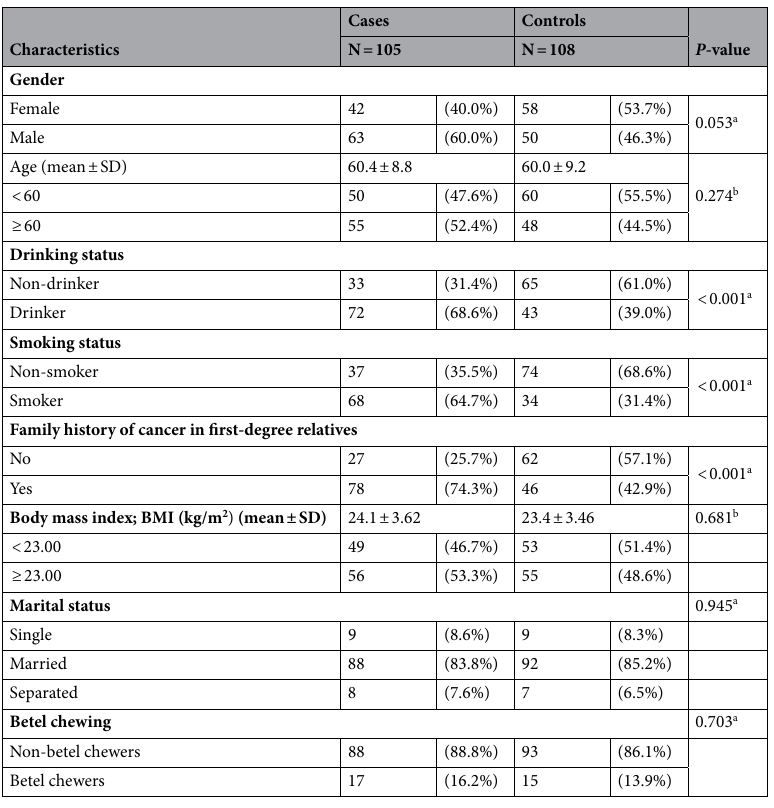
Table 1. Demographic characteristics of the oesophageal cancer cases and controls. a p ; p -value differences between cases and controls were detected using the Chi-squared test. b p ; p -value differences between cases and controls were detected using the Wilcoxon rank-sum